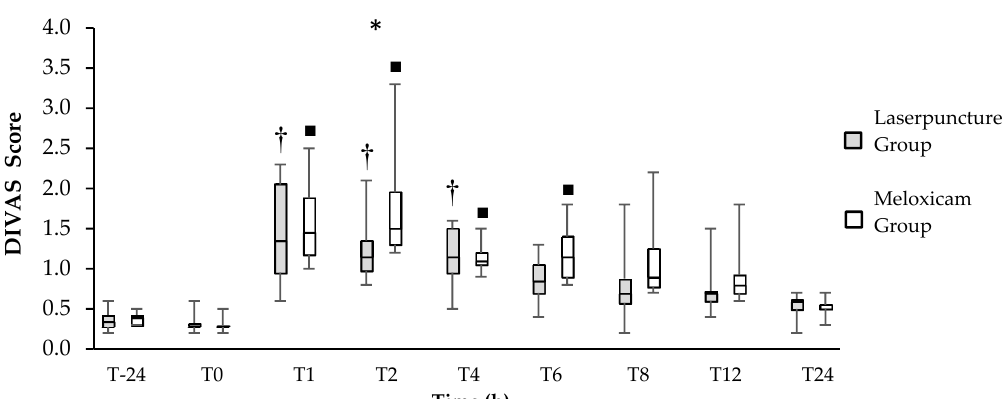
Figure 2. Box plot of the Dynamic Interactive Visual Analogue Scale (DIVAS) scores over time (center horizontal lines express the medians; box limits indicate the 25th and 75th percentiles, whiskers extend 10th and 90th percentiles) for 16 bitches treated preoperatively with laserpuncture ( n = 8) or meloxicam ( n = 8) and submitted to ovariohysterectomy. * Indicates the differences between groups at T2 ( p = 0.020) according to the Mann–Whitney test. † Indicates di ff erences between postoperative time points and T-24 and/or T0 in the Laserpuncture Group ( p < 0.05). ■ Indicates differences between postoperative time points and T-24 and/or T0 in the Meloxicam Group ( p < 0.05).